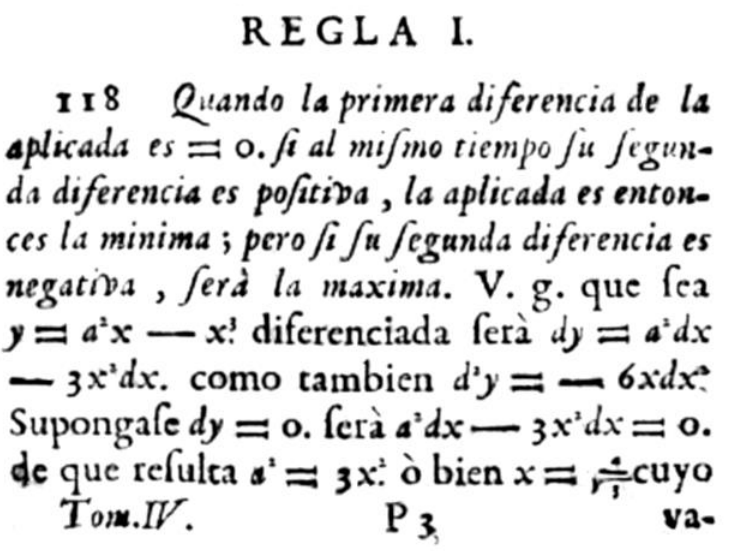
Figure 2. Rule I for testing whether a quantity is maximum or minimum. Source: Padilla and Arcos [54] (p.